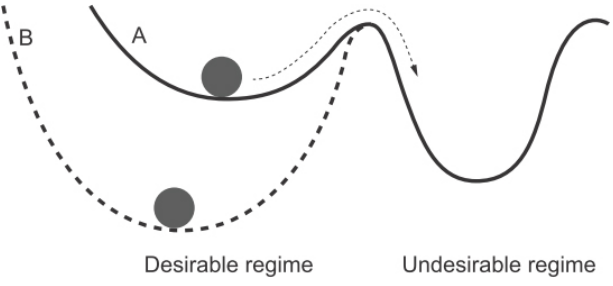
Fig. 3 . The tolerable range of socioeconomic state change dictates the shape or size of the basin of attraction that represents the desirable regime. A narrow range means a smaller, shallow basin (Case A), while a wider range leads to a larger, deeper basin (Case